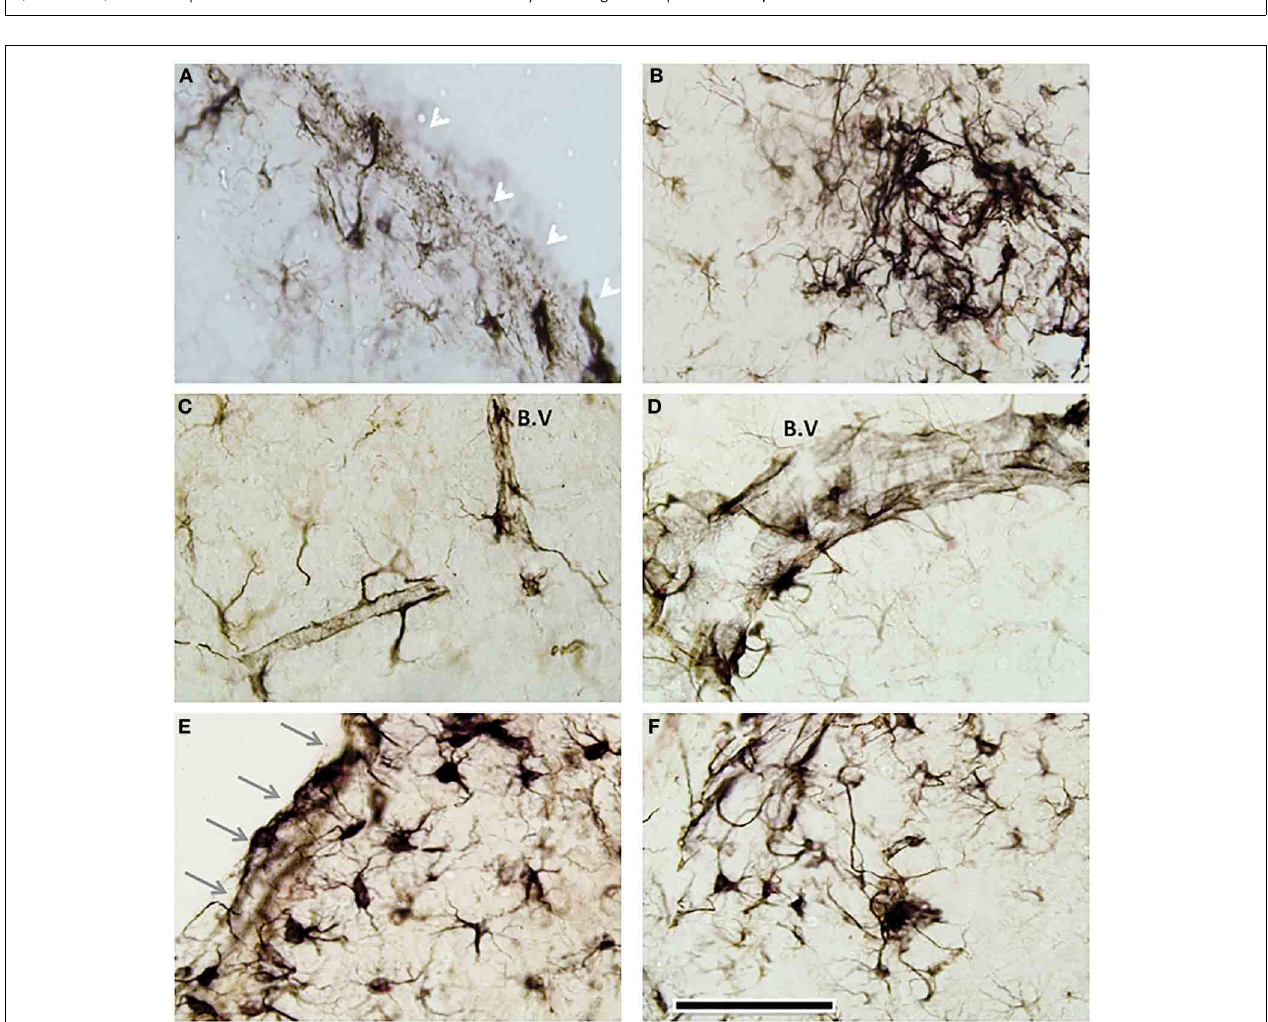
FIGURE 10 | Distinct periventricular and perivascular astroglia response to mTBI. GFAP immunostaining revealed a layer of GFAP + activated cells in the most superficial layer of the cortex (See white arrows in representative image— A ), beneath the injury site of head injured animals (in both mTBI and